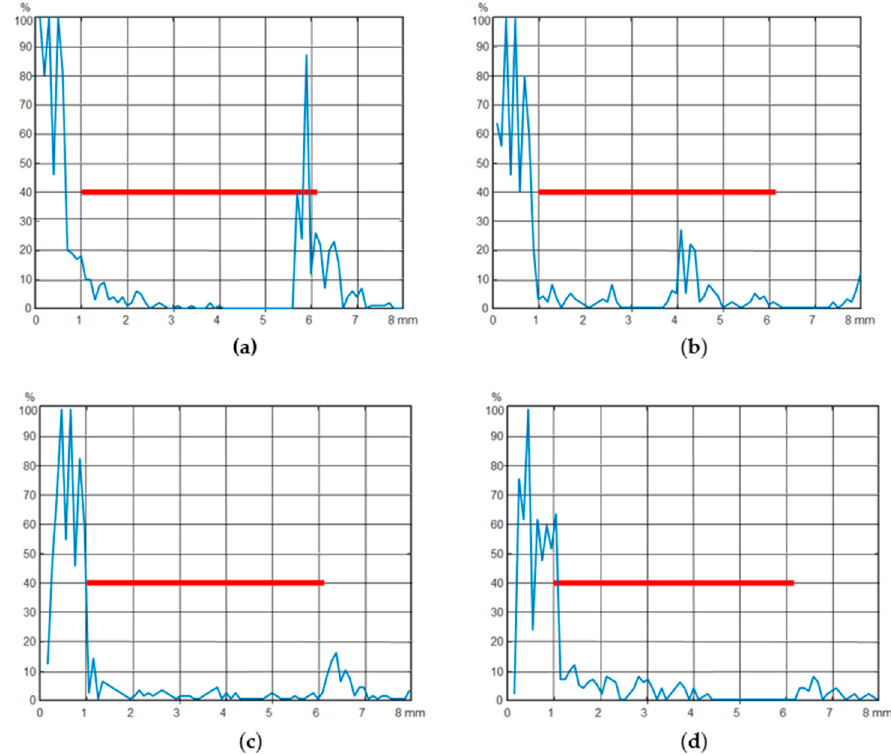
Figure 7. Echo signals of ultrasonic flaw detector during non-destructive testing of rivet joints: ( a ) is a normal rivet; ( b ) defect in the middle of the rivet at the 80% undercut; ( c ) defect in the middle of the rivet at the 50% undercut; ( d ) defect at the rivet cap base at the 50% undercut. The red line is a strobe for detecting defects. Rivet defects differ in the type of echo signal in relation to this strobe.